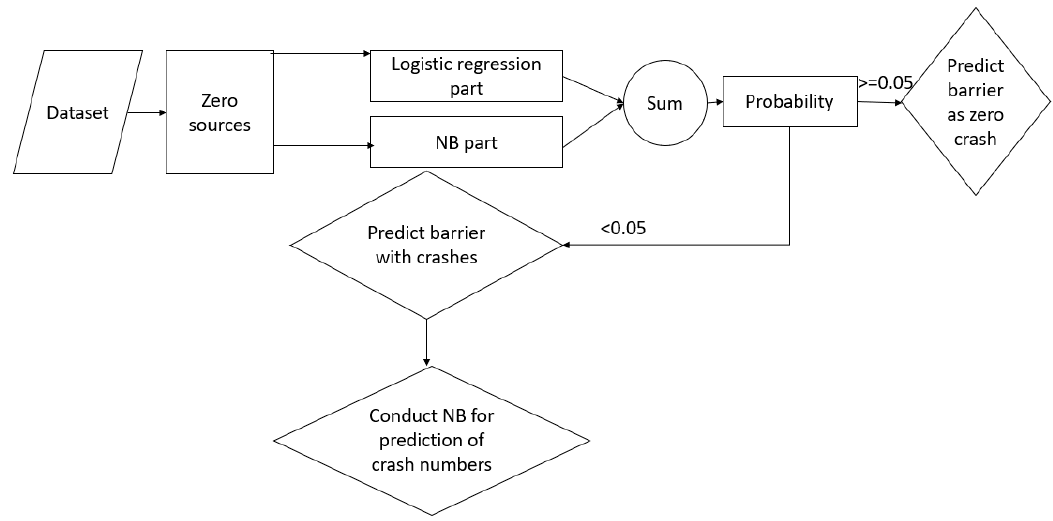
Figure 1. Two-component model methodological approach, ZINB.